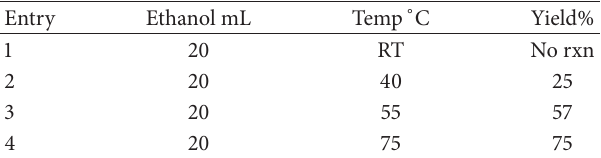
Table 4: Reductive amination reaction temperature.